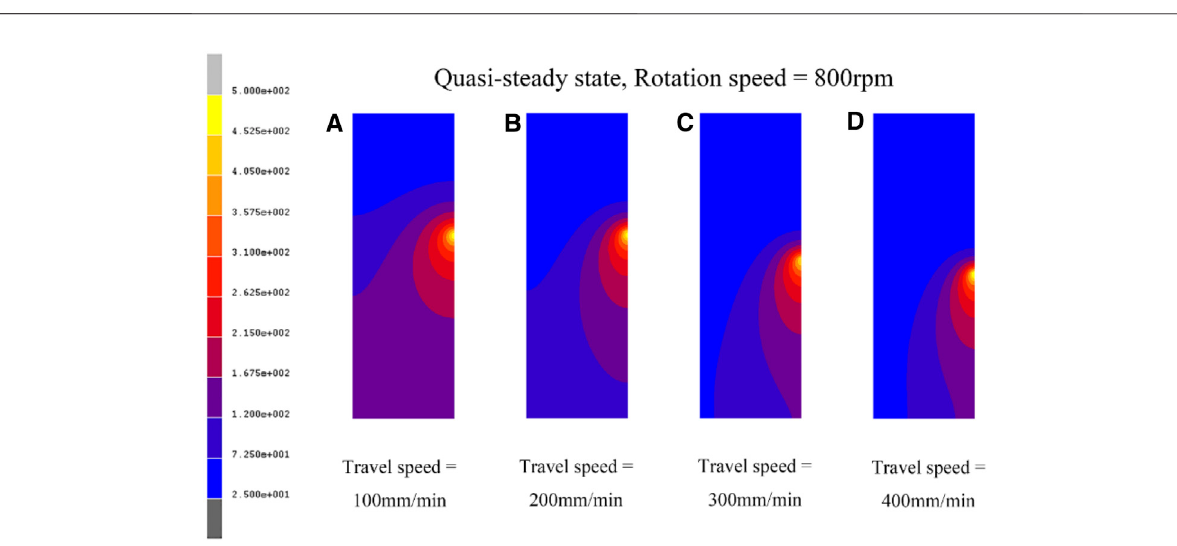
Frontiers in Materials |